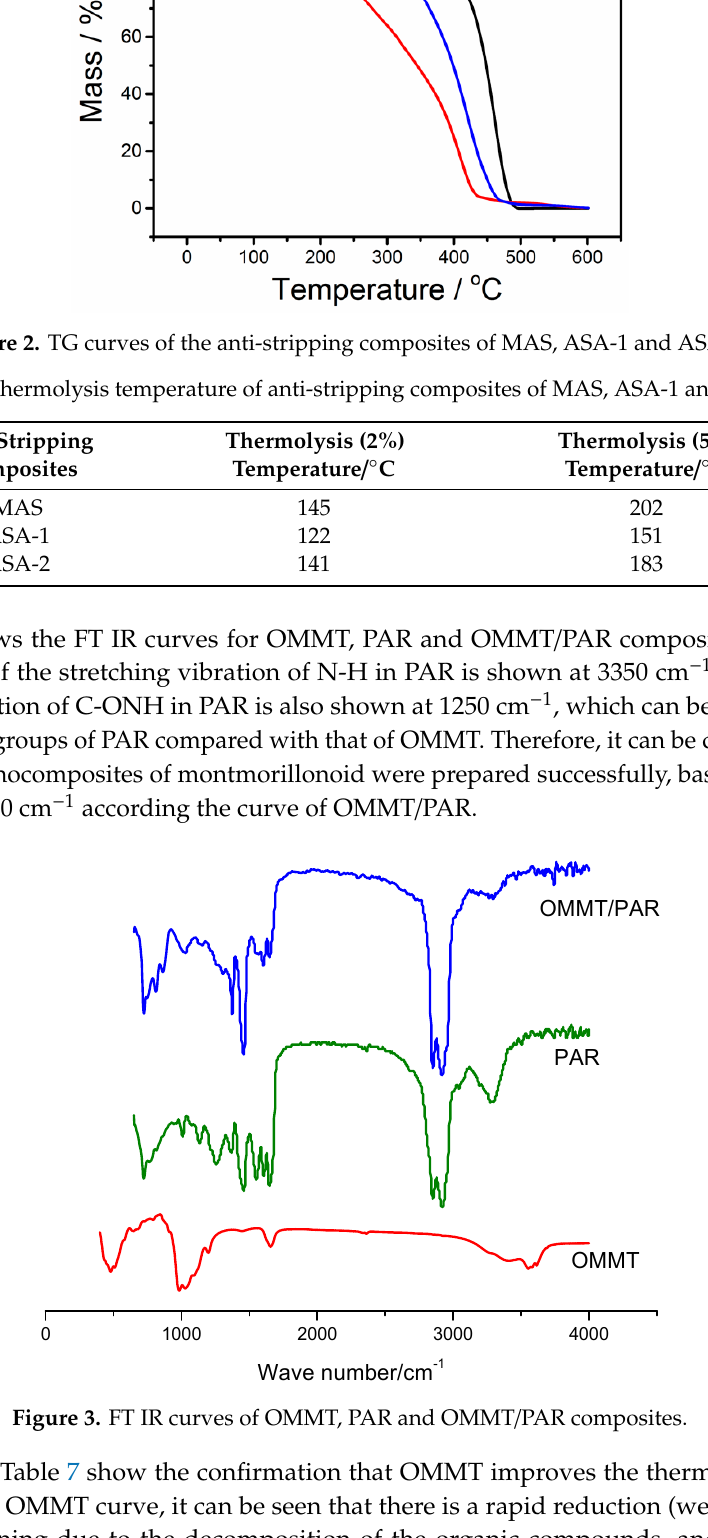
Figure 3. FT IR curves of OMMT, PAR and OMMT/PAR composites.